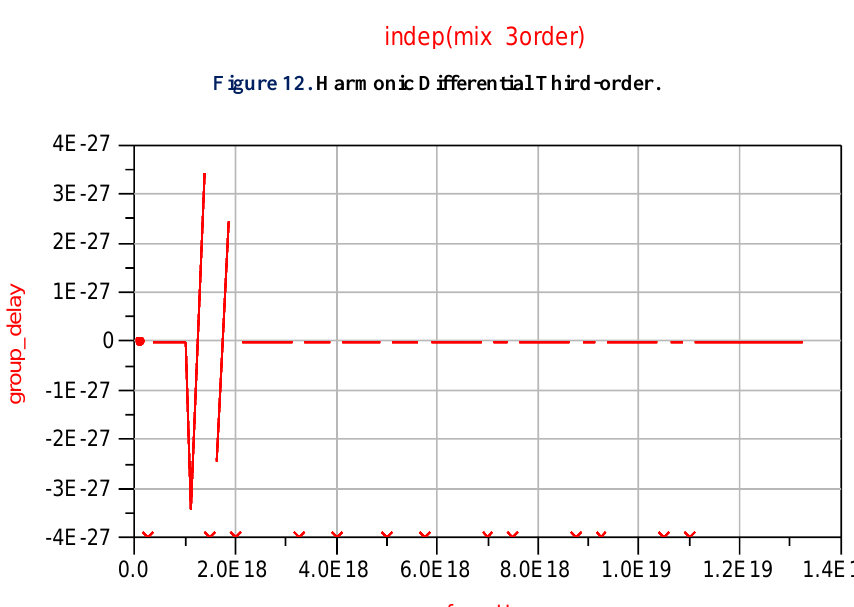
Figure 13. Characteristic of the harmonic phase harmonic frequency spectrum in terms of frequency.